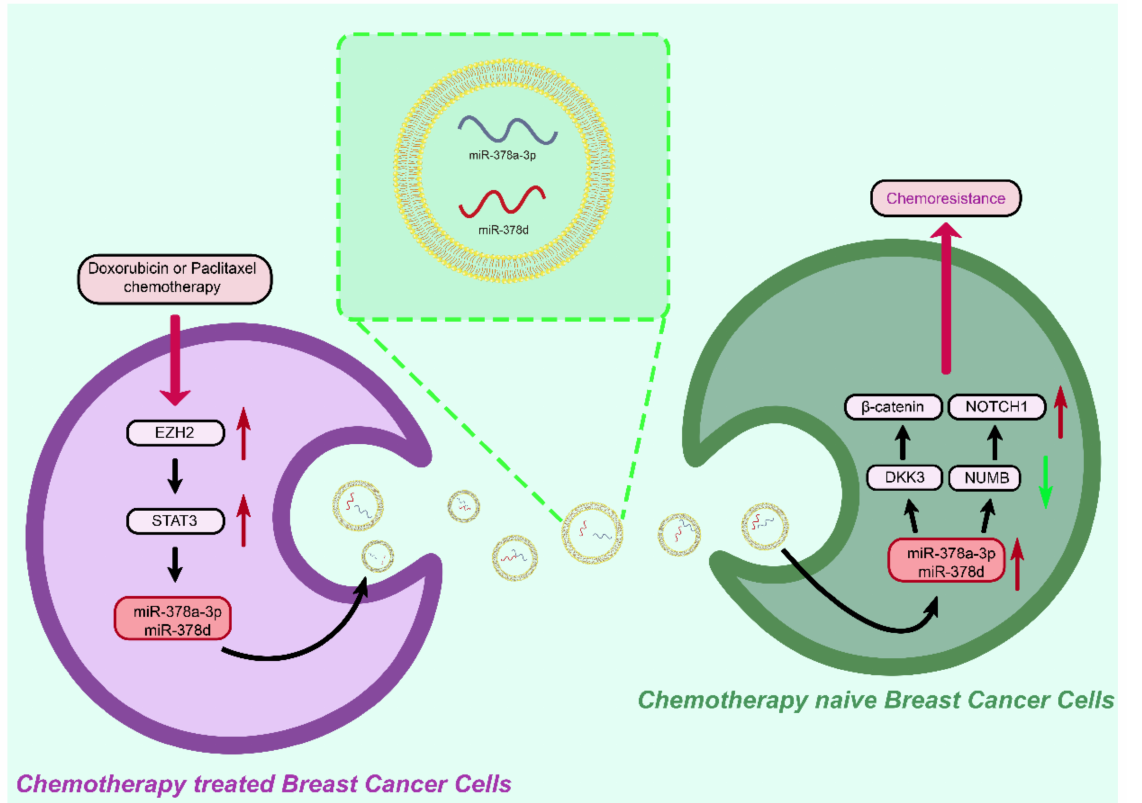
Figure 2. After activation of EZH2/STAT3 pathway, miR-378a-3p and miR-378d expression is increased in breast cancer cells treated with chemotherapy, which is released through exosome binding and endocytosis by surviving BC cells, resulting in